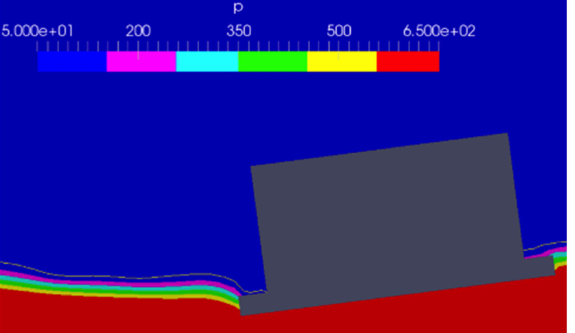
Figure 14. Pressure in the central vertical section of the floater (pitch phase 270